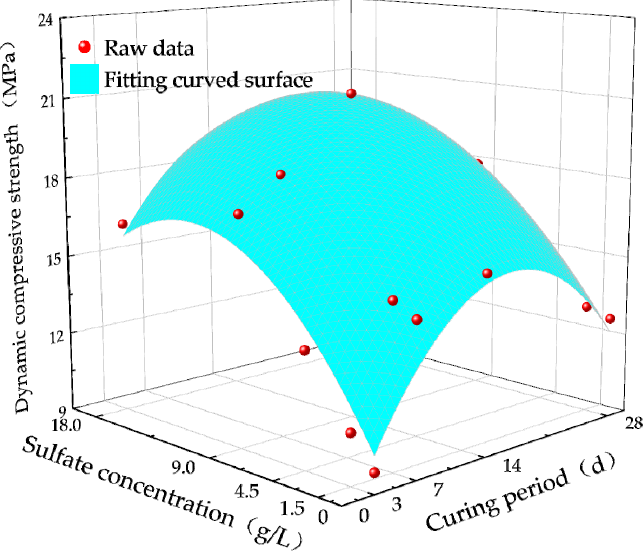
Figure 8. 3D fitting curved surface of dynamic compressive strength.